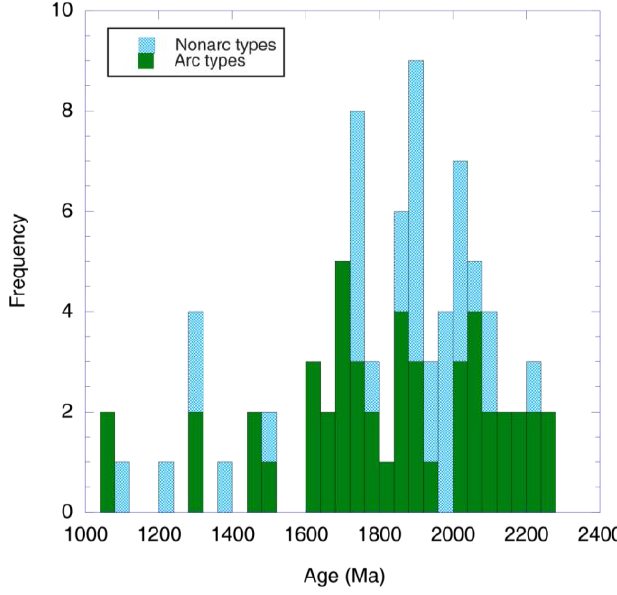
Figure 9. Frequency of arc and non-arc type greenstones preserved in Proterozoic orogens. Data from unpublished database of the author; earlier versions of the database can be found in [22,23].